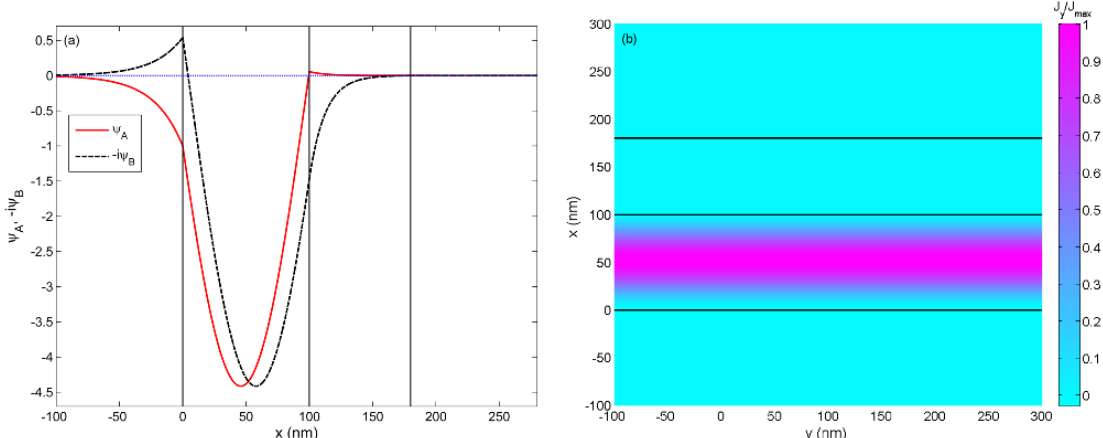
Figure 4. ( a ) the wave function of guided modes as a function of distance corresponding to the intersection ( k 2 x h 1 = 2.9257, θ = 69.8694 o ) in Figure 3a. The solid curve and the dashed lines corresponds to Ψ A and − i Ψ B , respectively. The vertical lines represent the boundaries of the waveguide; and ( b ) the corresponding probability current density within the graphene waveguide for the guided mode. The solid black lines represent boundaries of the waveguide.